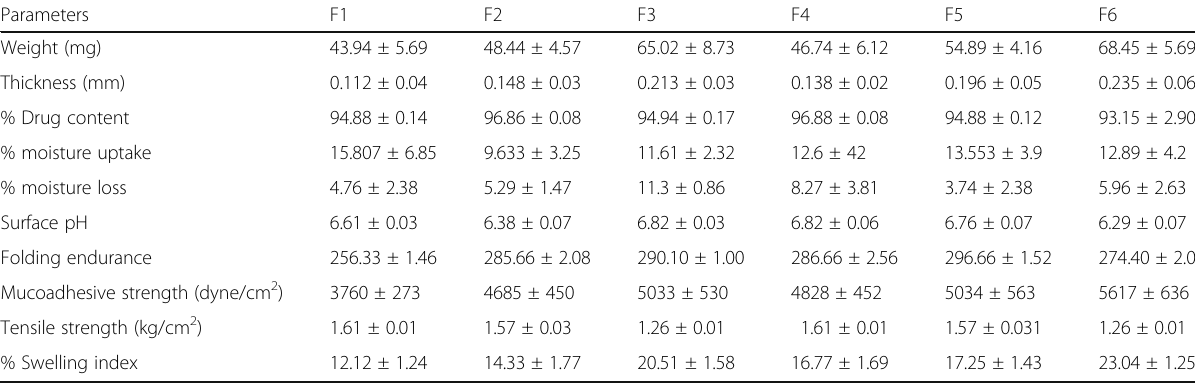
Table 3 Evaluation parameters of formulated films of piroxicam co-crystals